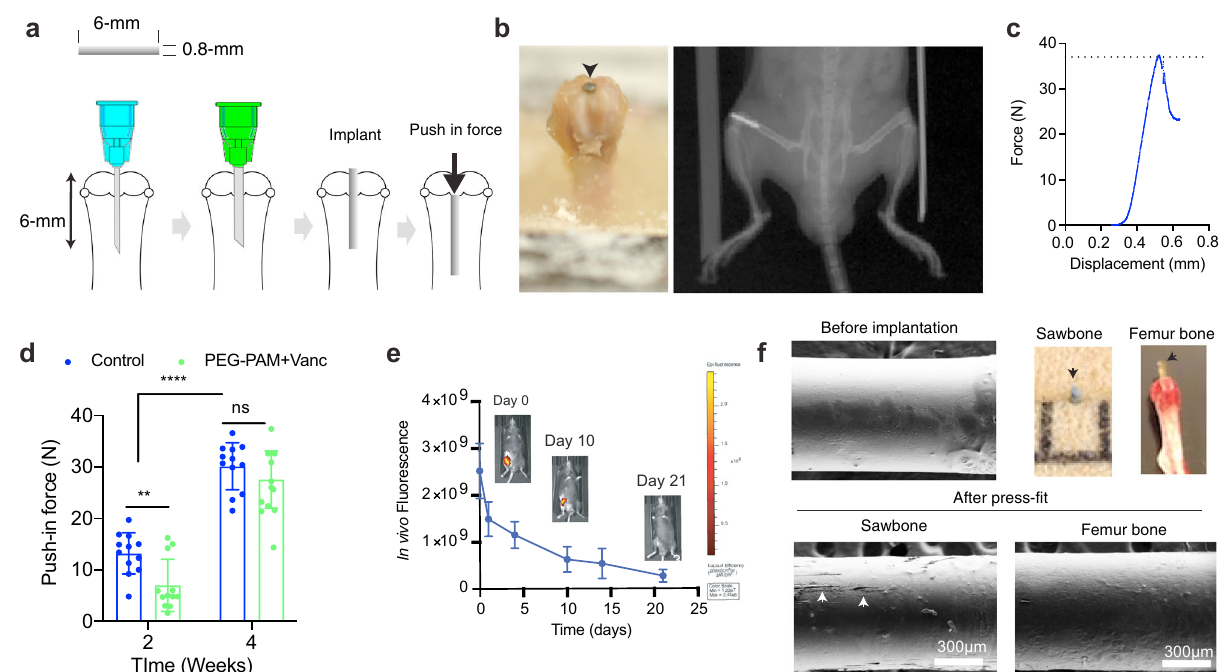
Fig. 4 PEG-PAM coating does not prevent long term osseointegration. a Schematic of the implant push-in test. Ti implants (0.8 mm diameter and 6 mm length) were prepared from K-wires and both edges were fl attened. b The distal femur of two groups of mice (24 in each group) were implanted with either a Ti implant that was coated with PEG-PAM/Vanc or a control untreated Ti implant. c At 2- and 4-weeks post-implantation, 12 mice from the PEG-PAM/ Vanc group and 12 mice from the control group were euthanized and femurs were harvested. A push-in test was performed and the load (N) to displacement was measured as the implant push-in value. The maximal push-in force (shown with a dotted line in c ) is then plotted for all the biological replicates. d In both the control and the PEG-PAM/Vanc coated implant group there was a statistical increase in the mean load to displacement from 2 – 4 weeks. While the mean load to displacement was signi fi cantly lower in the PEG-PAM/Vanc coated group at 2 weeks, there was no difference between the groups 4-weeks post-implantation. Each animal is represented by a dot and were considered biological replicates. Biological replicates are shown ( n = 12) and data are plotted as the mean ± standard deviation. e In vivo biodegradation of PEG-PAM coating labeled with Cy5.5 maleimide using in vivo fl uorescence imaging ( n = 3). The fl uorescence scale shown was obtained directly from the IVIS imaging scanner. Data is plotted showing the Mean and Standard Deviation. f The PEG-PAM/Vanc coated Ti implants were press- fi t into PCF 10 Sawbones block and into cadaver mouse femurs (color images in this panel). The implants were subsequently retrieved and examined by SEM to characterize the mechanical stability of the implant. Characteristic surface abrasions on the PEG-PAM/Vanc coating can be seen and denoted by a white arrow. Statistics in ( d ) are a two-way-repeated measure-ANOVA with multiple comparisons post-test. The signi fi cance between treatment groups ** p =